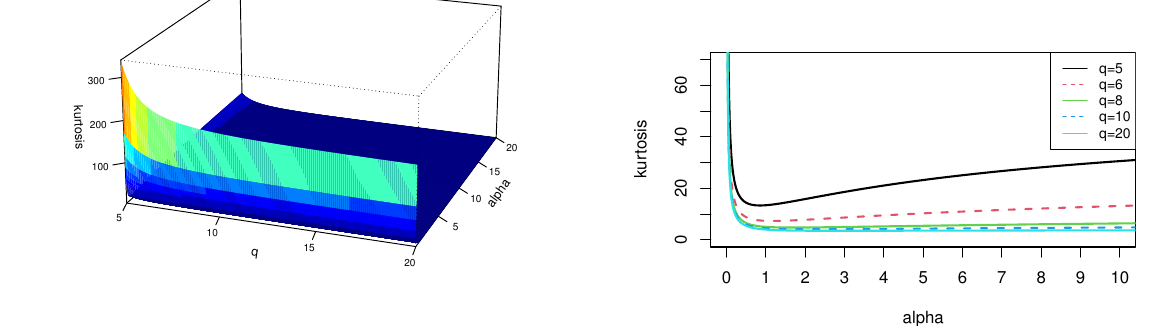
Figure 5. Plots of the kurtosis coefficient in the SPHN model.